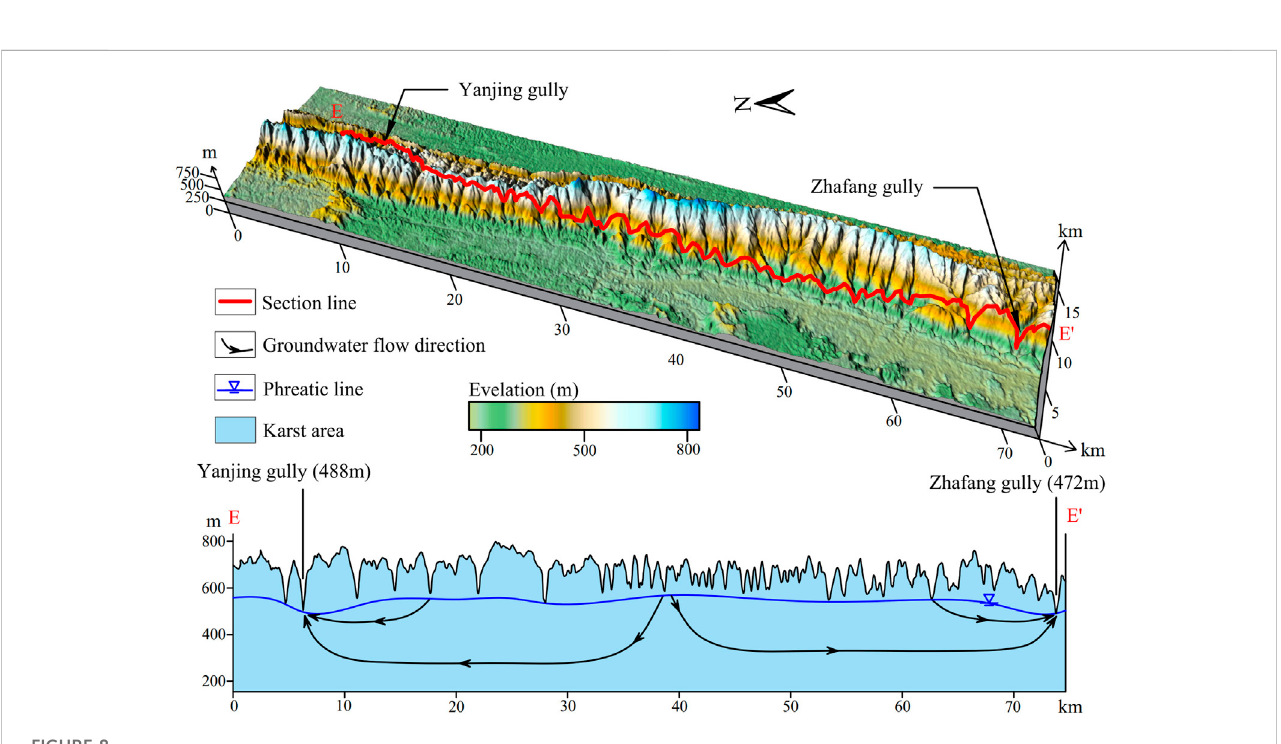
gully with a large control range appeared, which controls the discharge of groundwater in the trough valley together with the shallow transverse gullies. Isotope sampling data from the middle section